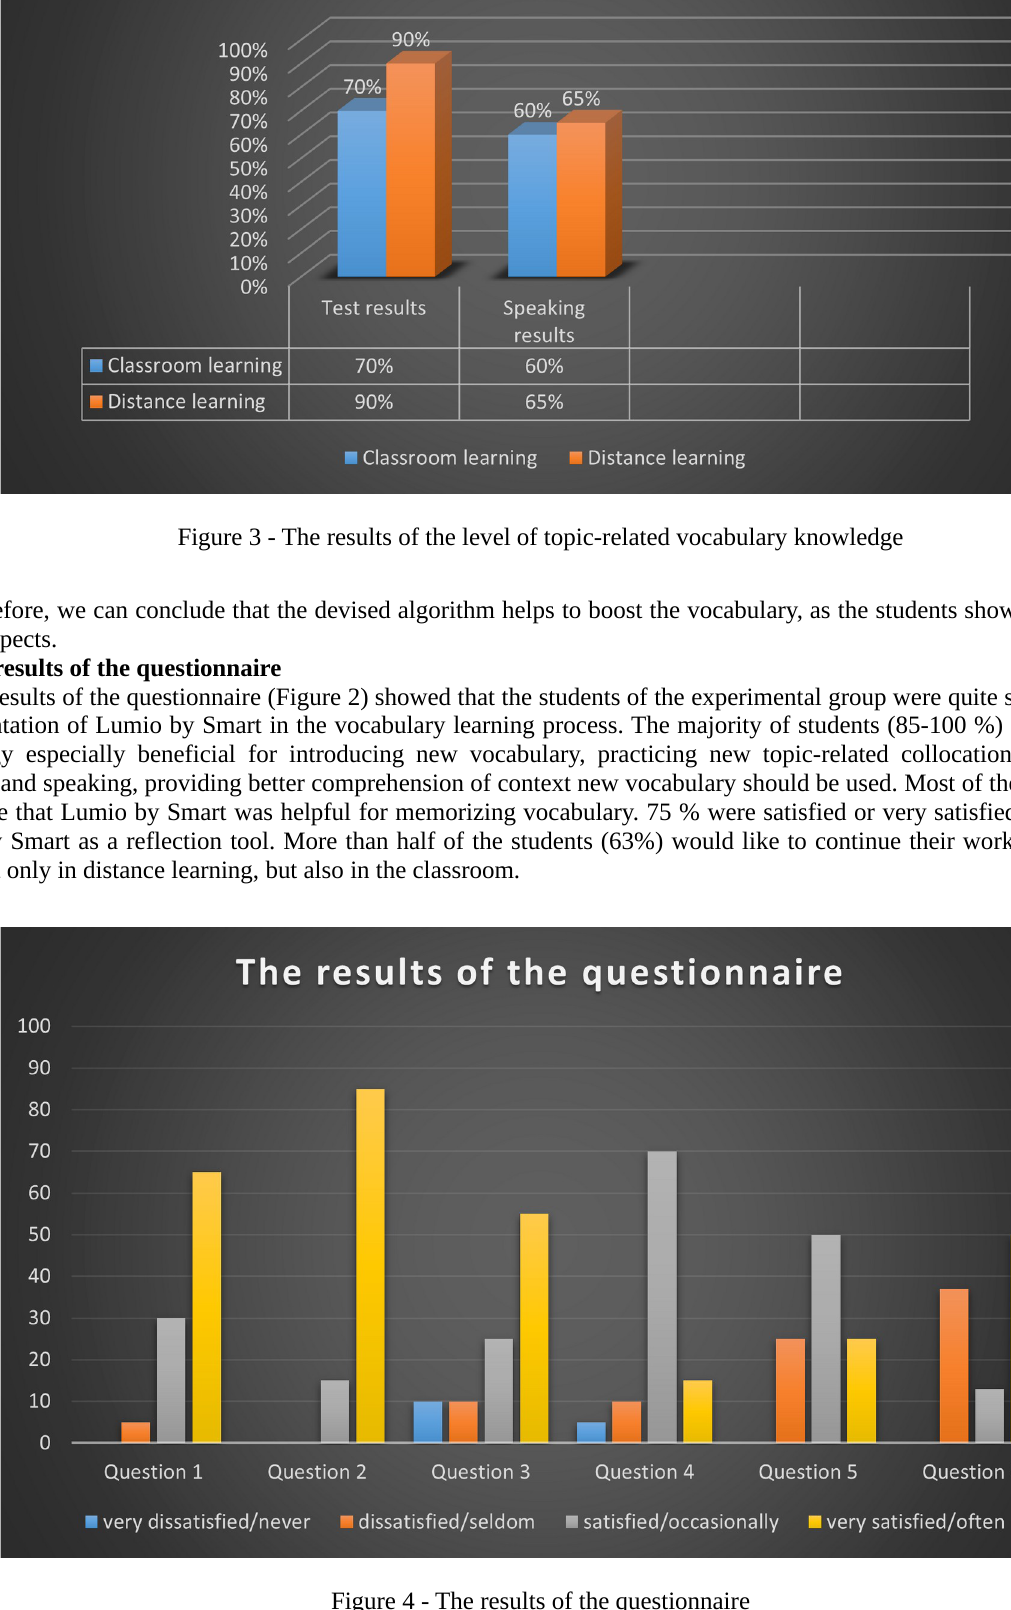
Figure 4 - The results of the